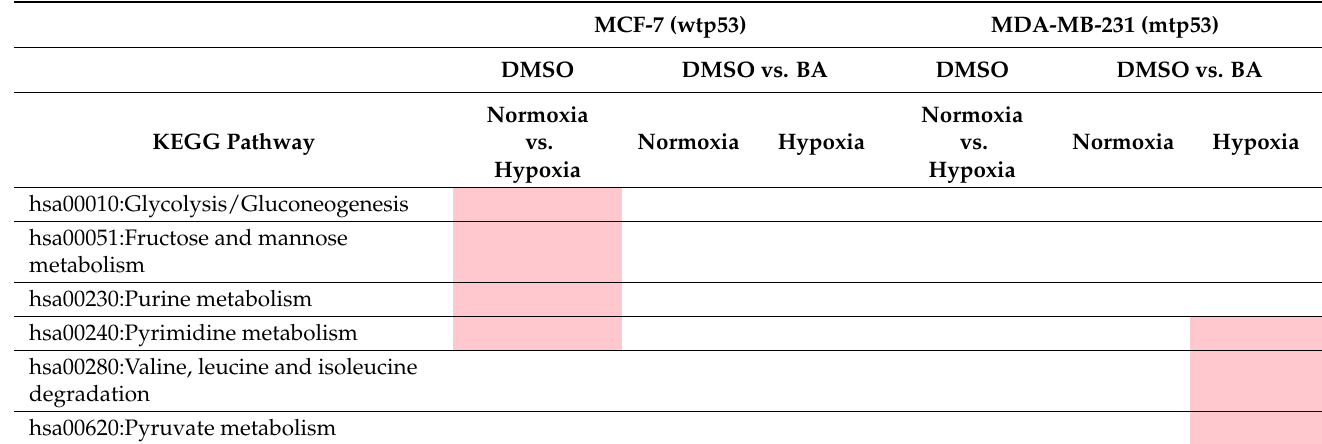
Table 3. Induced KEGG pathways in breast cancer cells under hypoxia compared to normoxia (MCF-7: column 1 and MDA-MB-231: column 4), as well as after treatment with 10 µ M BA compared to DMSO treatment under normoxia (MCF-7: column 2 and MDA-MB-231: column 5) or hypoxia (MCF-7: column 3 and MDA-MB-231: column 6). Red label corresponds to significant regulated KEGG pathways (Benjamini-Hocberg adjusted p <